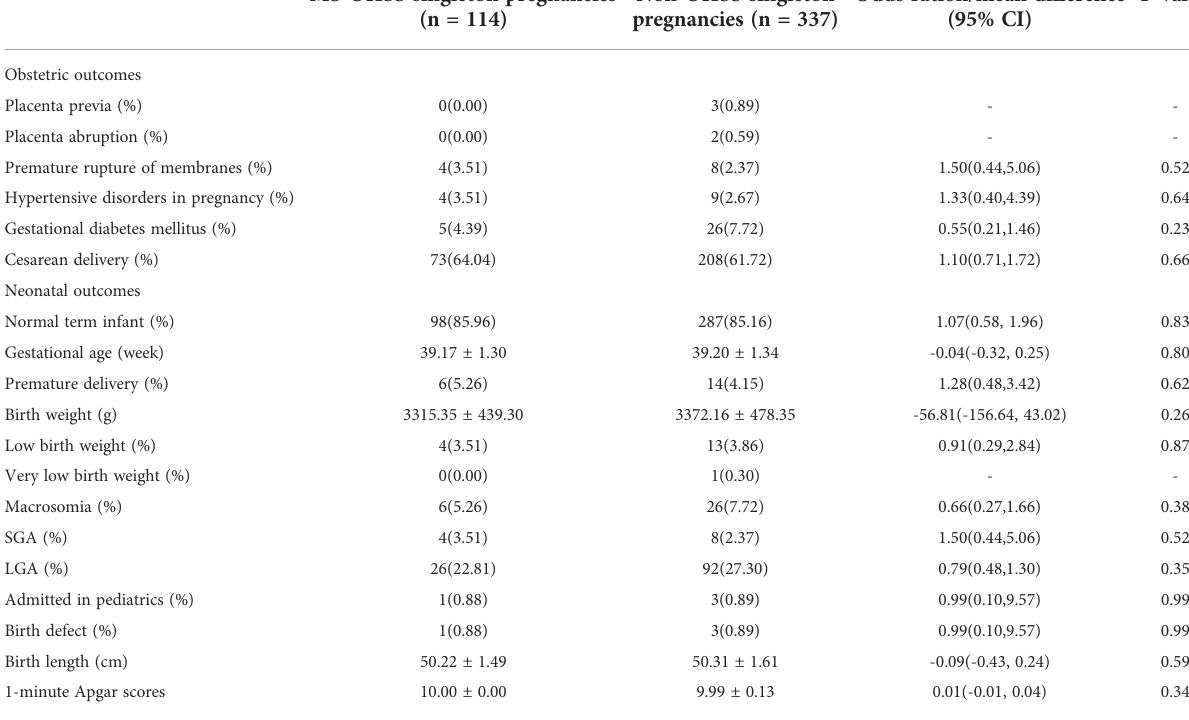
TABLE 3 Perinatal outcomes among MS-OHSS patients and Non-OHSS patients after propensity score